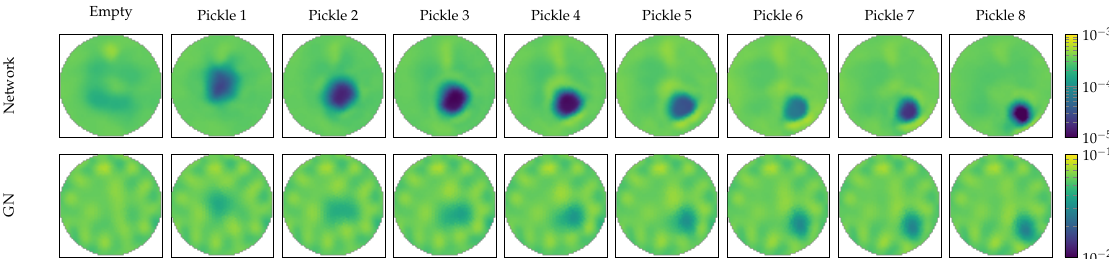
Figure 7. Illustration of RF-REIM-NET and GN reconstructions on the pickle measurements of the tank dataset. The empty measurement was not used in both reconstructions, and is given only for a better view of the reconstruction artifacts. Pickle 1 is the center pickle, while Pickle 7 is the outer